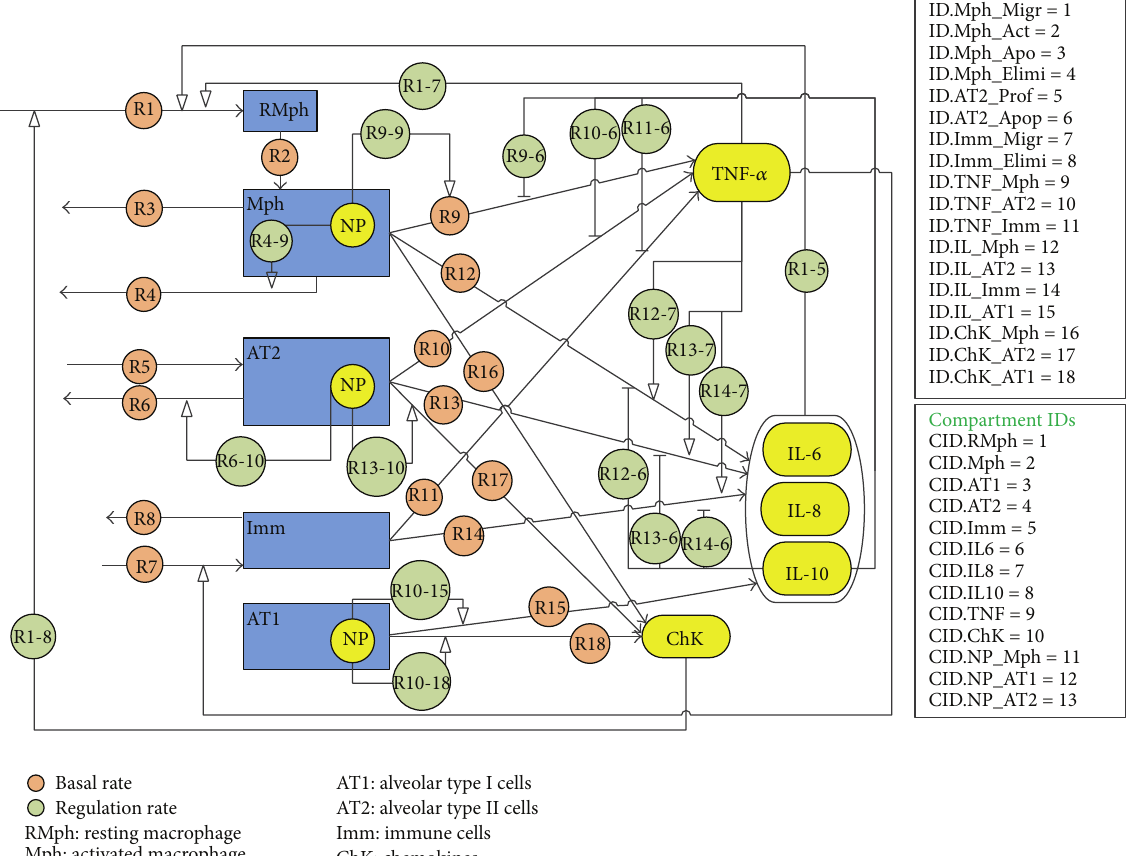
Figure 2: Cellular interaction, migration, and cytokine secretion of four cell types in the pulmonary alveolar subsystem for a proposed in vivo toxicodynamic model. The diagram includes macrophages, alveolar type I and alveolar type II cells, and immune cells, including cell-cell regulatory and signaling pathways. 𝑅1 , 𝑅2 , and so forth are the basal kinetic rates of the various cellular processes; 𝑅 𝑖−𝑗 is the rate of regulation of process 𝑅 𝑖 by the cell or chemical in CID 𝑗 . All process and compartment IDs are listed on the right. (The diagram follows the standards of the Systems Biology Graphical Notation (SBGN); see